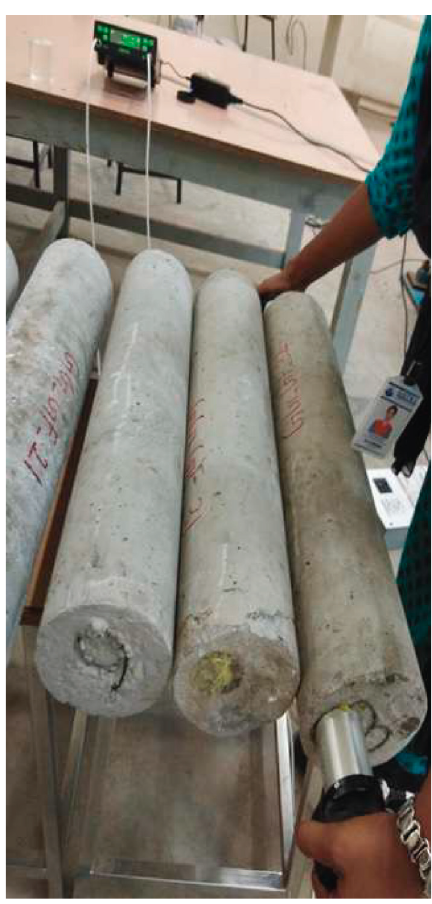
Figure 9: UPV test being conducted on column specimens.